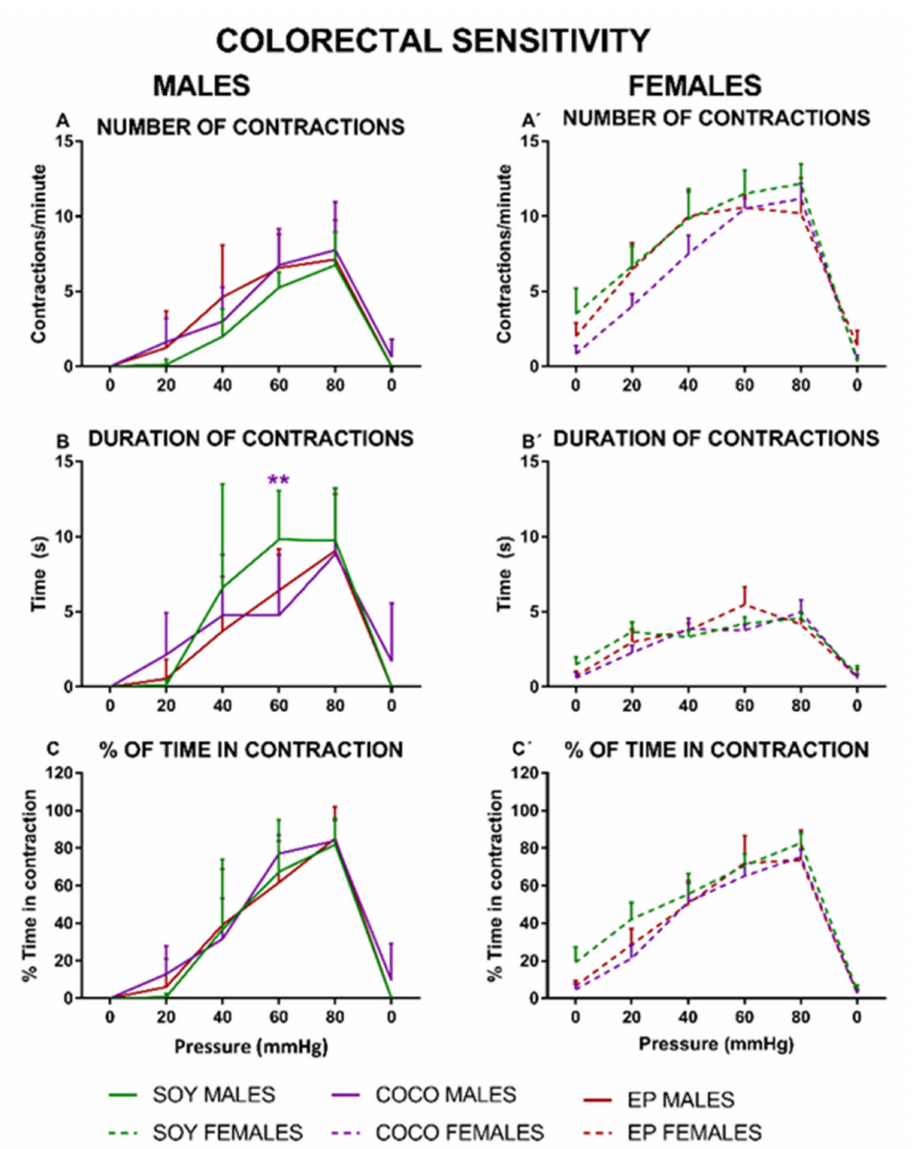
Figure 10. Effects of diet intervention on colonic sensitivity in the rat. Male ( A – C ) and female ( A’ – C’ ) rats were exposed to AIN-93G diet containing 7% of soybean oil (SOY), or to modified AIN-93G diet containing 3.5% of soybean oil supplemented with 3.5% of coconut oil (COCO) or with 3.5% of evening primrose oil (EP). Colonic sensitivity was measured as the number of abdominal contractions ( A , A’ ), duration of the contractions ( B , B’ ), and % of time in contraction ( C , C’ ) in response to intracolonic mechanical phasic stimulation (0–80 mmHg, each stimulus lasting for 20 s, 3 stimuli per pressure interval, separated by 60 s). Data were analyzed in males and females, separately. Data are presented as mean ± S.D. ( n = 6–8 per group). Two-way ANOVA followed by Bonferroni’s multiple comparison. ** p < 0.01 vs. SOY